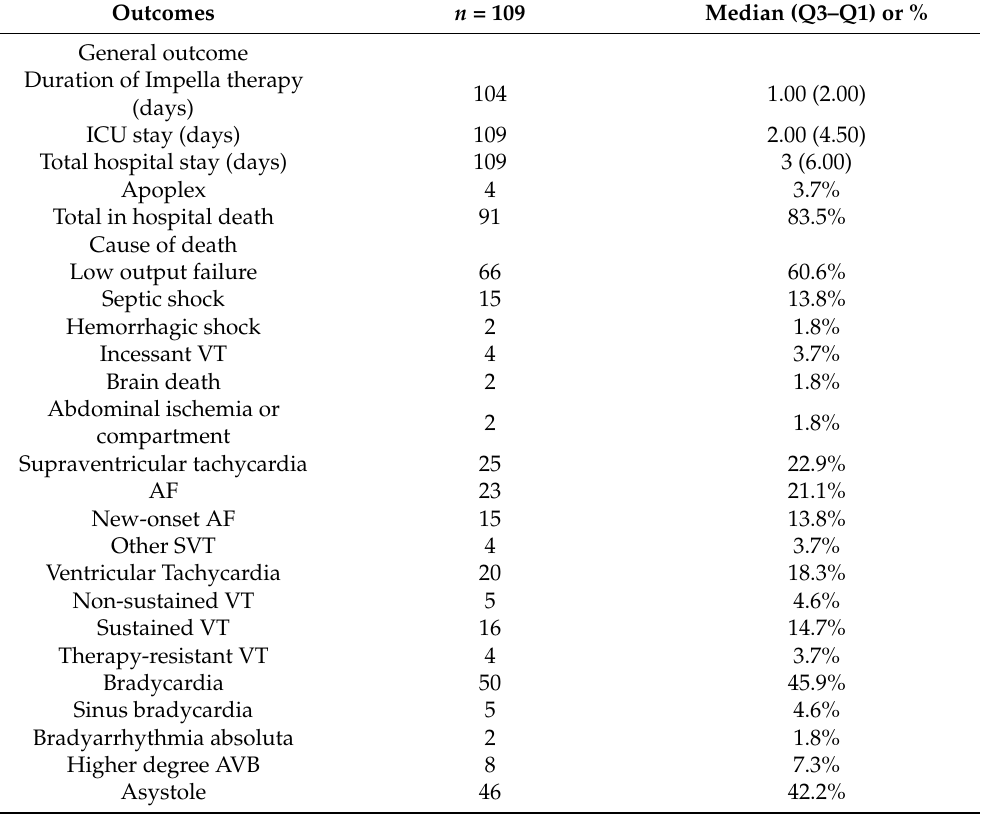
Table 2. Outcomes and incidence of relevant arrhythmias during ICU monitoring of Impella